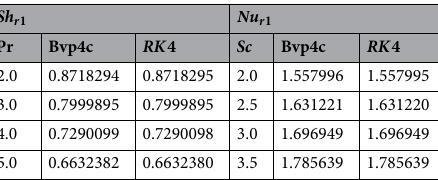
Table 3. The comparison of RK 4 and Bvp4c for Sherwood Sh r 1 and Nusselt number Nu r 1 at the lower disk, when M = 1.2, Sc = 3.0, Pr = 3.0, Nt = Nb = 0.3, Re = 4.0, β 1 = 0.2, S 1 = S 2 = 0.5.